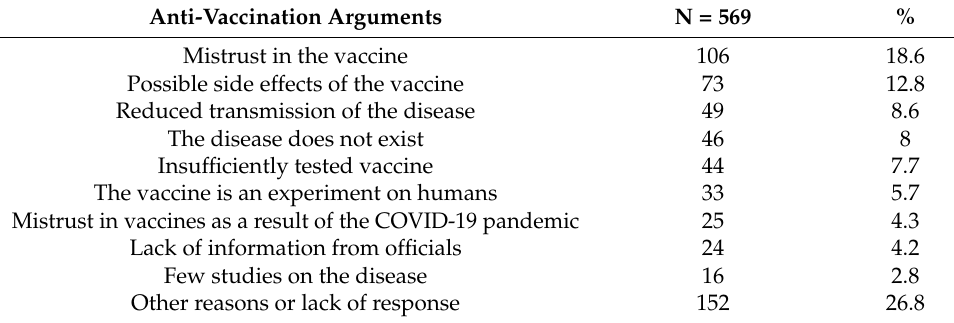
Table 7. Arguments of participants who do not accept vaccination against